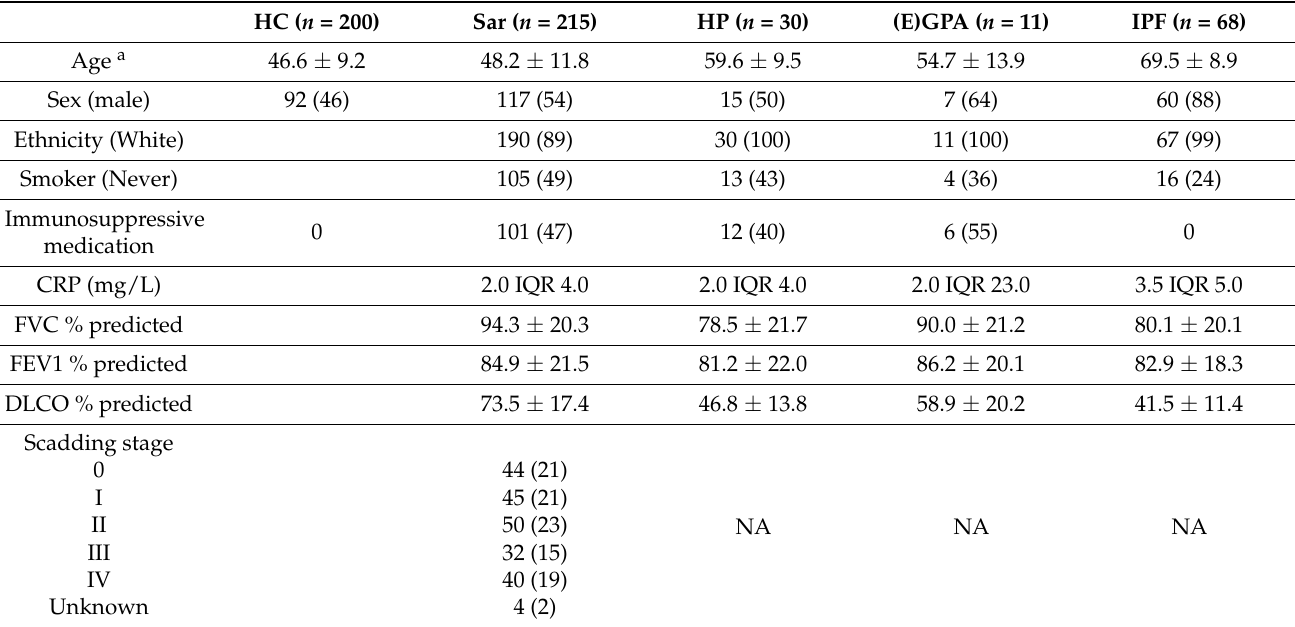
Table 1. Demographics of study